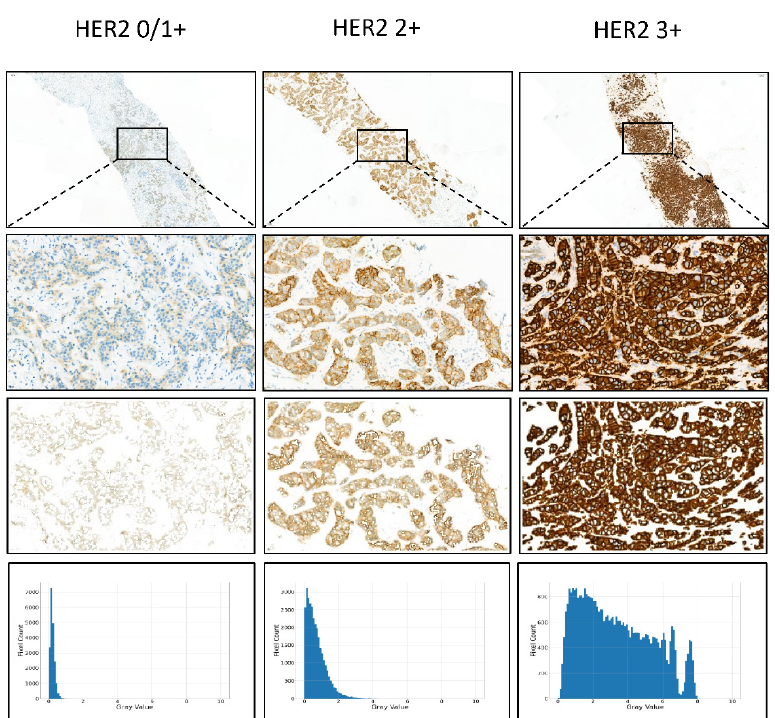
Figure 3. Examples of GrayMap of HER2 IHC expression. Typical examples of HER2 0/1+, 2+, 3+ cases in IBC-NST. From top to bottom: HER2 IHC raw images, magnified images, cell membrane segmentation, and pixels’ gray value’s distribution of the